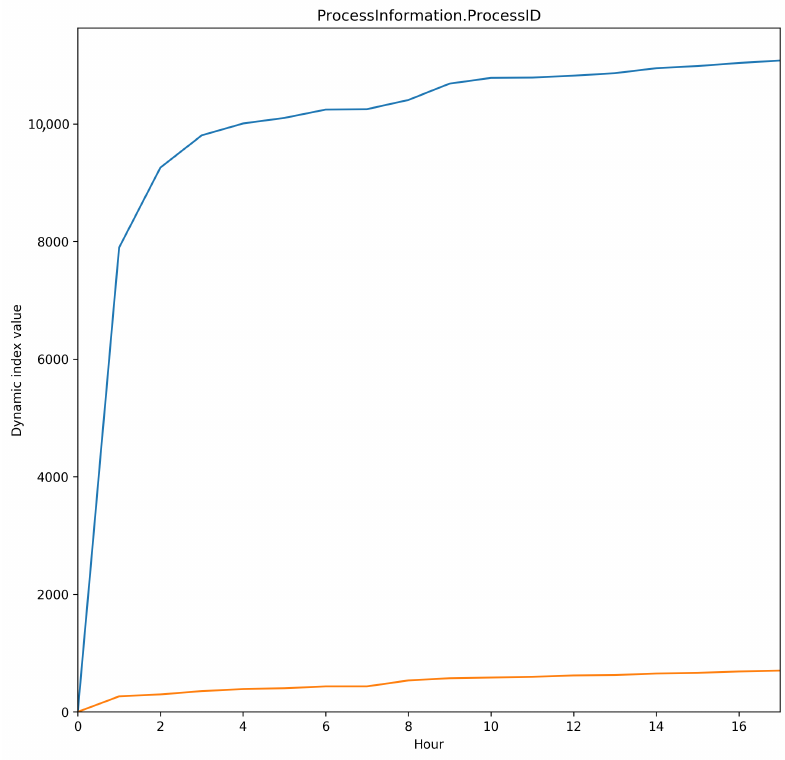
Figure 8. Dynamic indexes for the ProcessInformation.ProcessID event property.